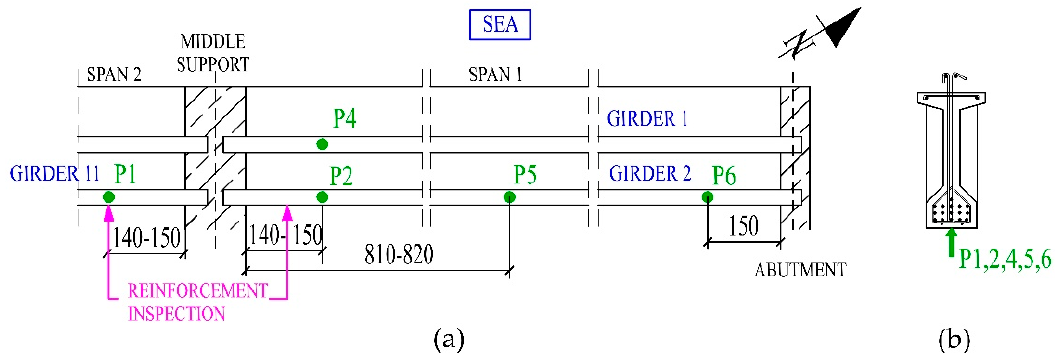
Figure 3. Locations P1, P2, P4, P5, and P6 for chloride sampling (distances in cm): ( a ) girder layout; ( b ) girder cross section.